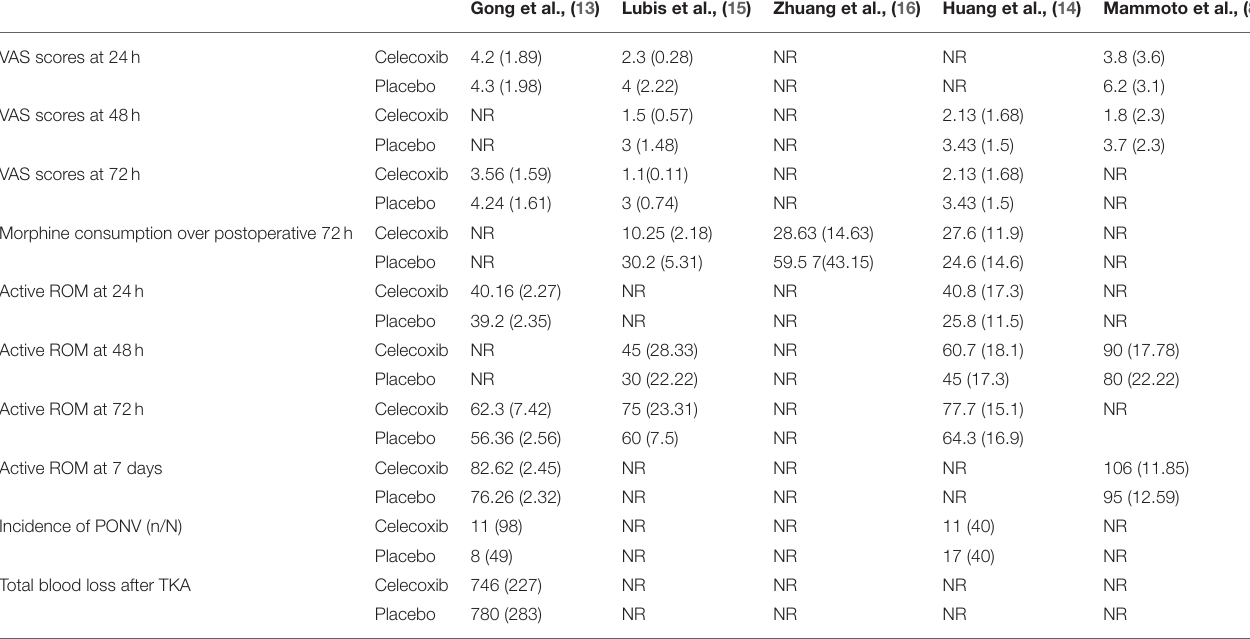
TABLE 2 | Main outcomes of each included